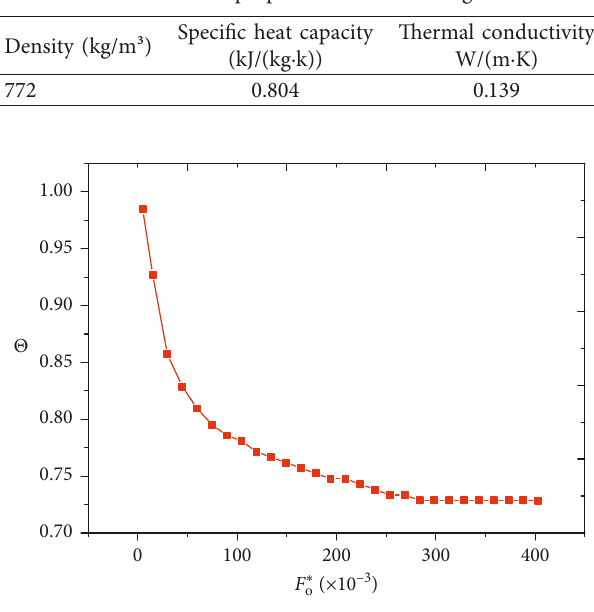
Table 2: Thermal properties of surrounding rocks.